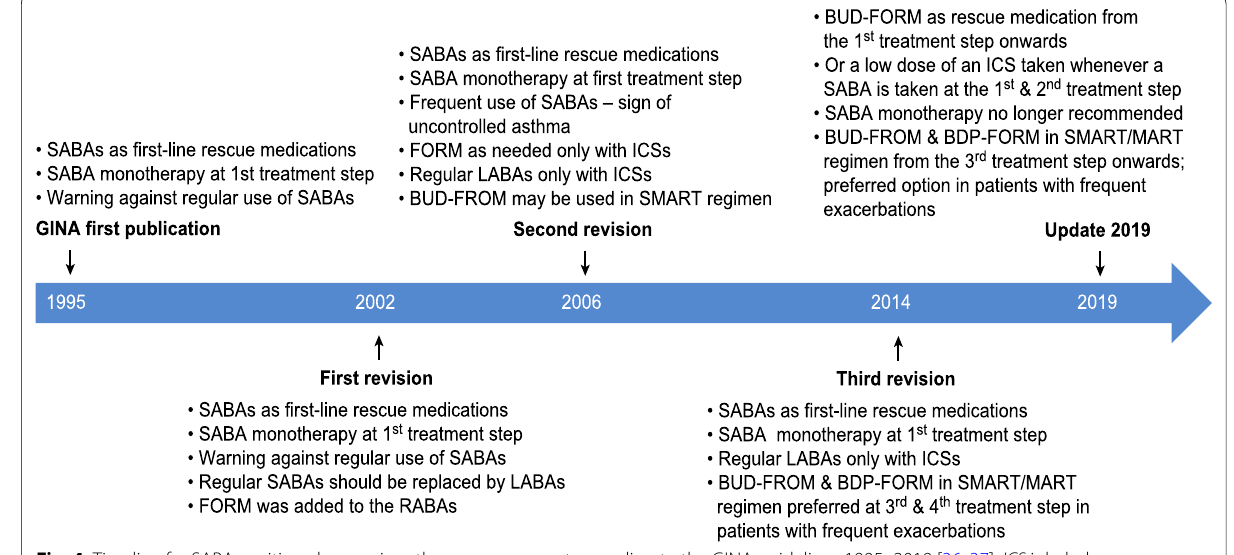
Fig. 4 Timeline for SABA position changes in asthma management according to the GINA guidelines 1995–2019 [36, 37]. ICS inhaled corticosteroids, LABA long acting beta2 agonist, RABA rapid acting beta2 agonist, SABA short acting beta2 agonist, SMART single inhaler maintenance and rescue therapy, MART maintenance and rescue therapy, BUD budesonide, BDP beclomethasone, FORM